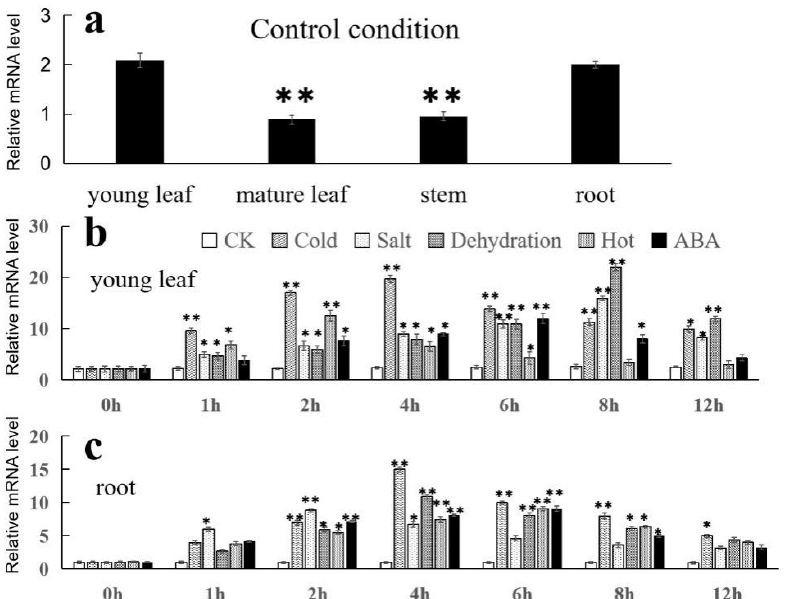
Figure 4. Quantitative RT-PCR analysis of the FvMYB44 expression pattern in F. vesca . ( a ) FvMYB44 expression in various tissues under non-stress conditions. ( b , c ) Expression of FvMYB44 in new leaves and roots over time in the presence of control and dehydration (15% PEG6000), heat (37 °C), cold (4 °C), salt (200 mM NaCl), and abscisic acid (100 M ABA). The standard deviation is indicated by error bars. The error bars with asterisks above them show that the treatment and control groups differ significantly from one another. (* p ≤ 0.05, ** p ≤ 0.01).